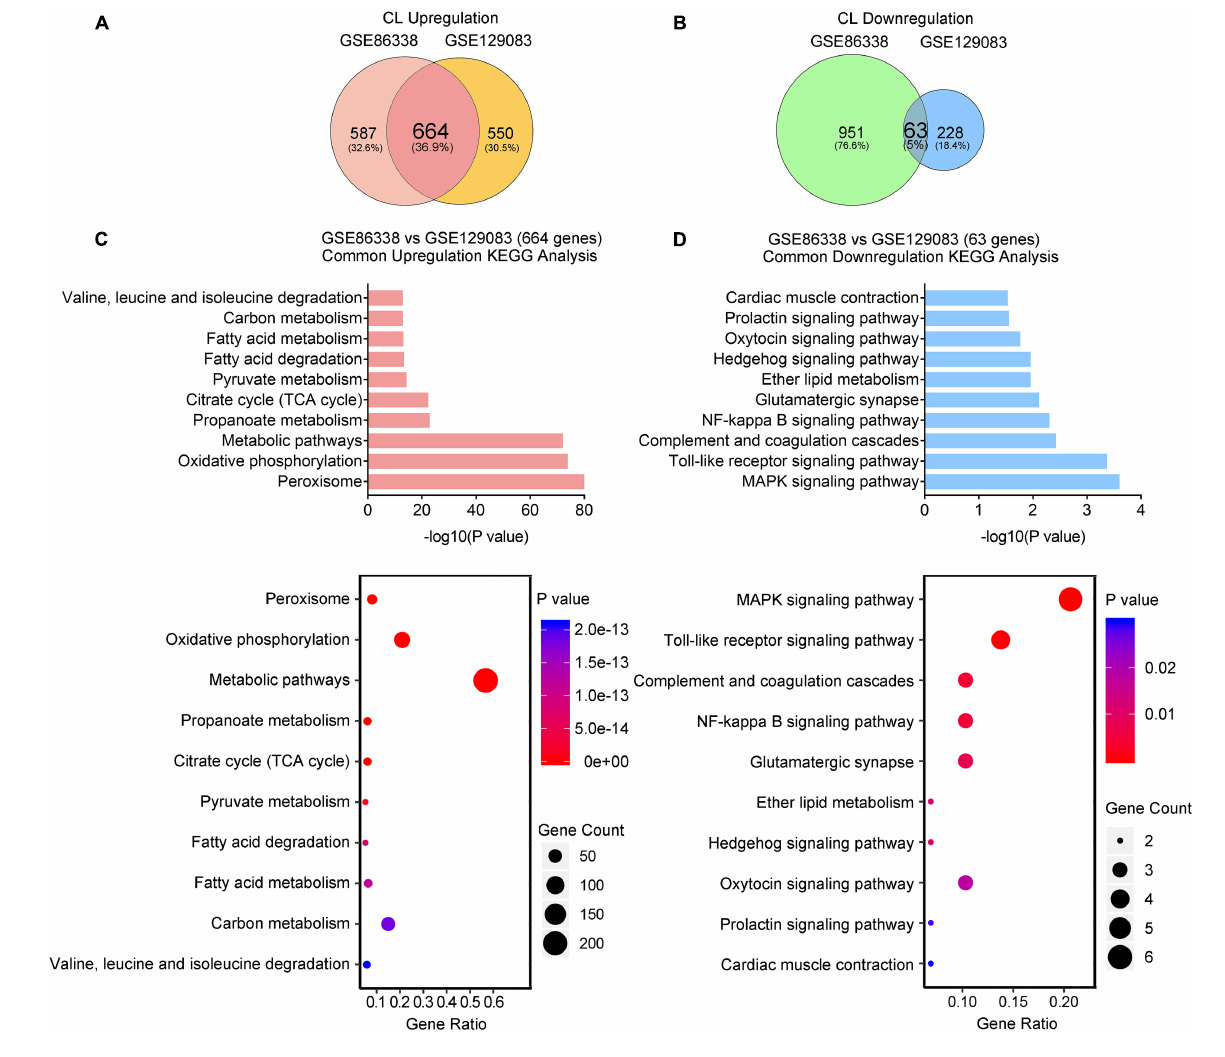
FIGURE 5 | CL stimulates a broader spectrum of metabolic gene pathways and decreases immune responses. (A,B) Venn diagram of overlapped upregulated (A) and downregulated (B) genes from iWAT of mice administrated with CL shown in GSE86338 and GSE129083 datasets. (C,D) KEGG analysis for the DEGs of common upregulated 664 genes (C) shown in (A) and downregulated 63 genes (D) shown in (B)